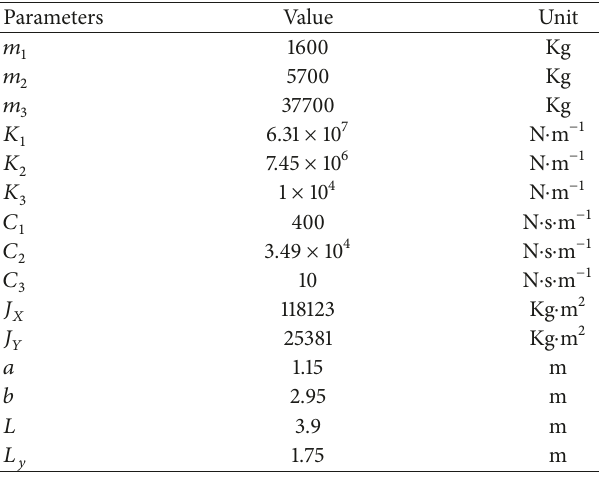
Table 1: Initial parameters of simulation. Parameters